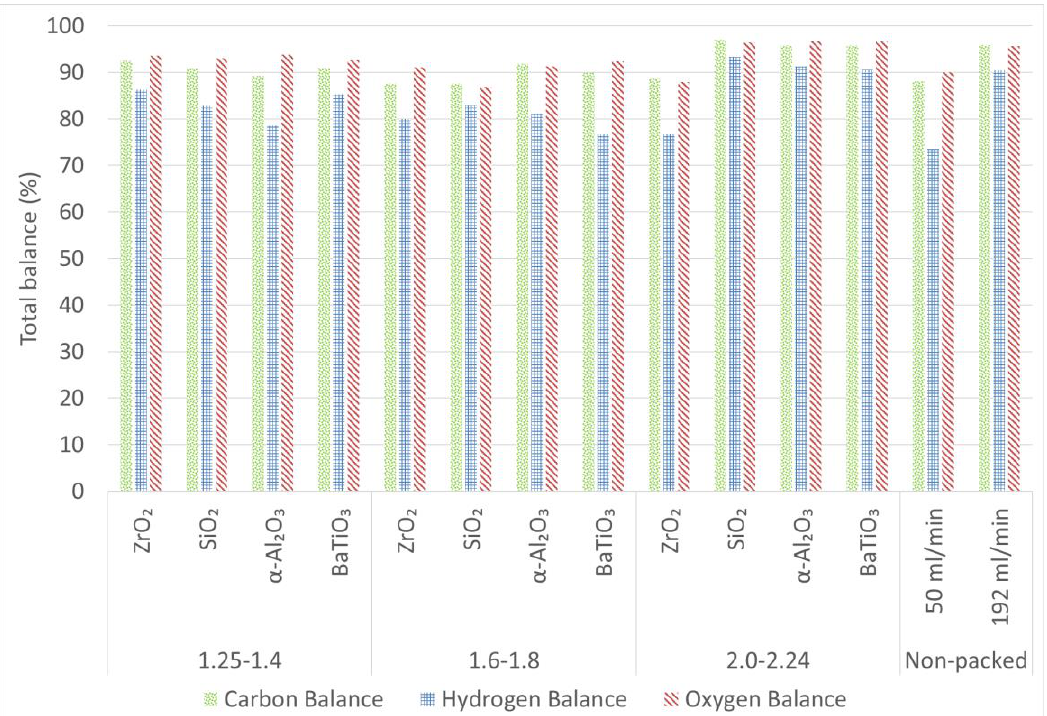
Figure 6. Carbon, Hydrogen and oxygen balance for different sphere sizes and materials, as well as the non-packed reactor.